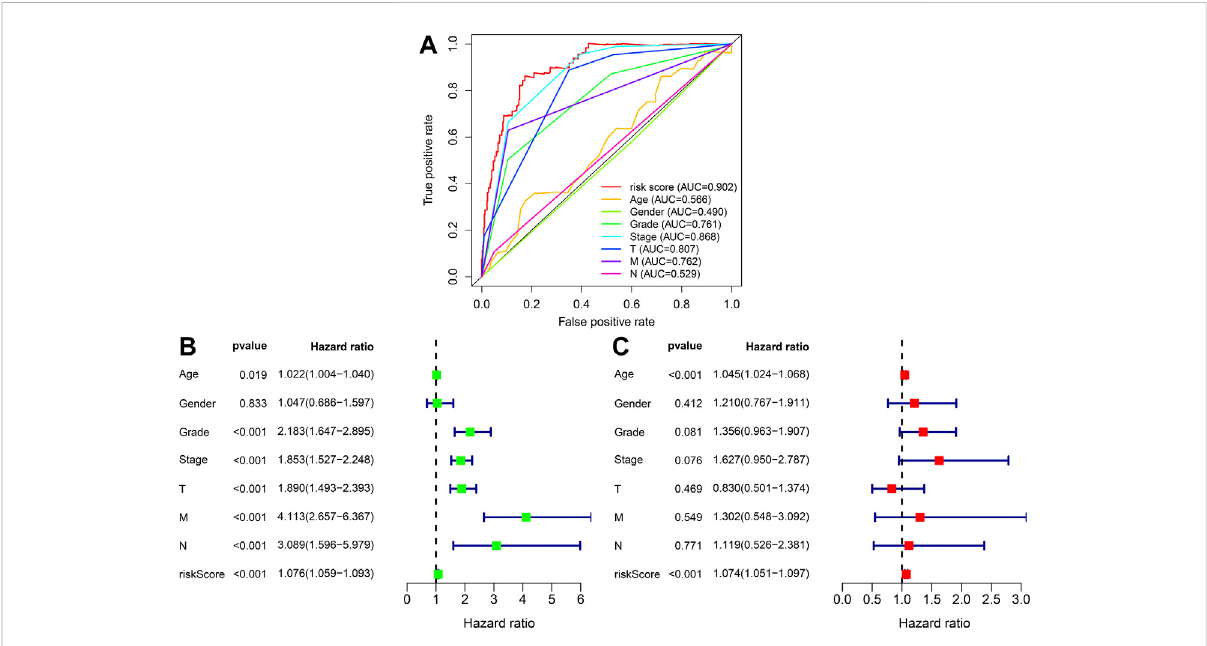
FIGURE 6 To assess forecasted independence of the prognostic marker for ccRCC prognosis. (A) 1-year ROC pro fi le shows a higher risk score compared toothercommonclinicopathologicalfeatures. (B) UnivariateCoxregressionanalysisofriskscoreandclinicopathologicalcharacters. (C) Multivariate Cox regression analysis of risk score as well as clinic pathological